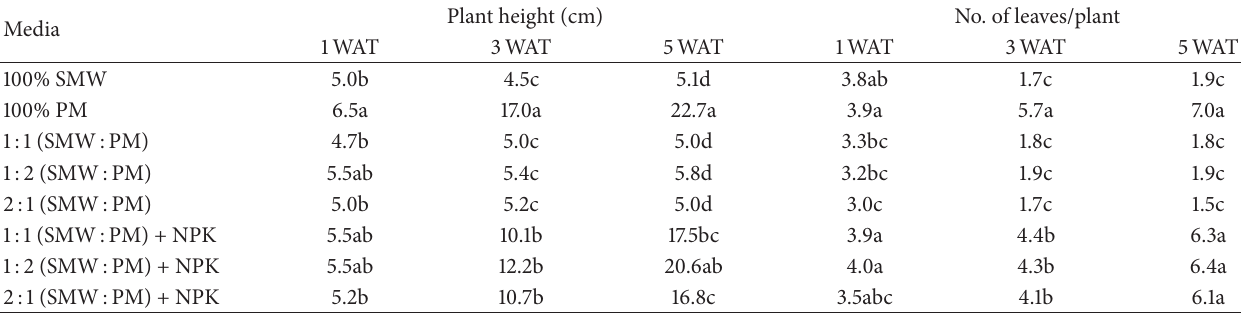
Table 2: Plant height (cm) and number of leaves/plant of Kai-lan as influenced by planting media at different growth stages. Plant height (cm) No. of leaves/plant Media 1WAT 3WAT 5 WAT 1WAT 3 WAT 100% SMW 5.0b 100% PM